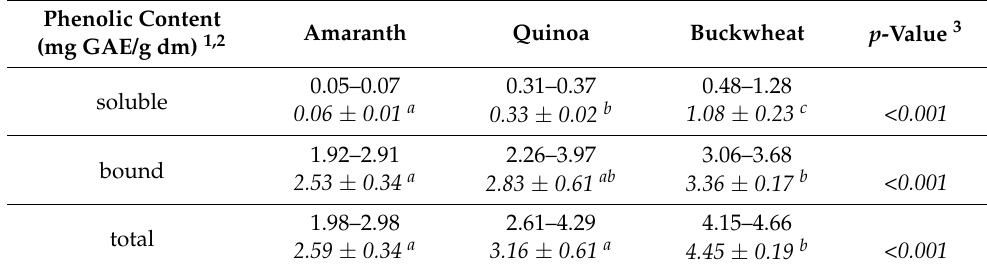
Table 6. Phenolic content (mg GAE/g dm) of amaranth ( n = 8), quinoa ( n = 7) and buckwheat ( n = 10) wholemeal